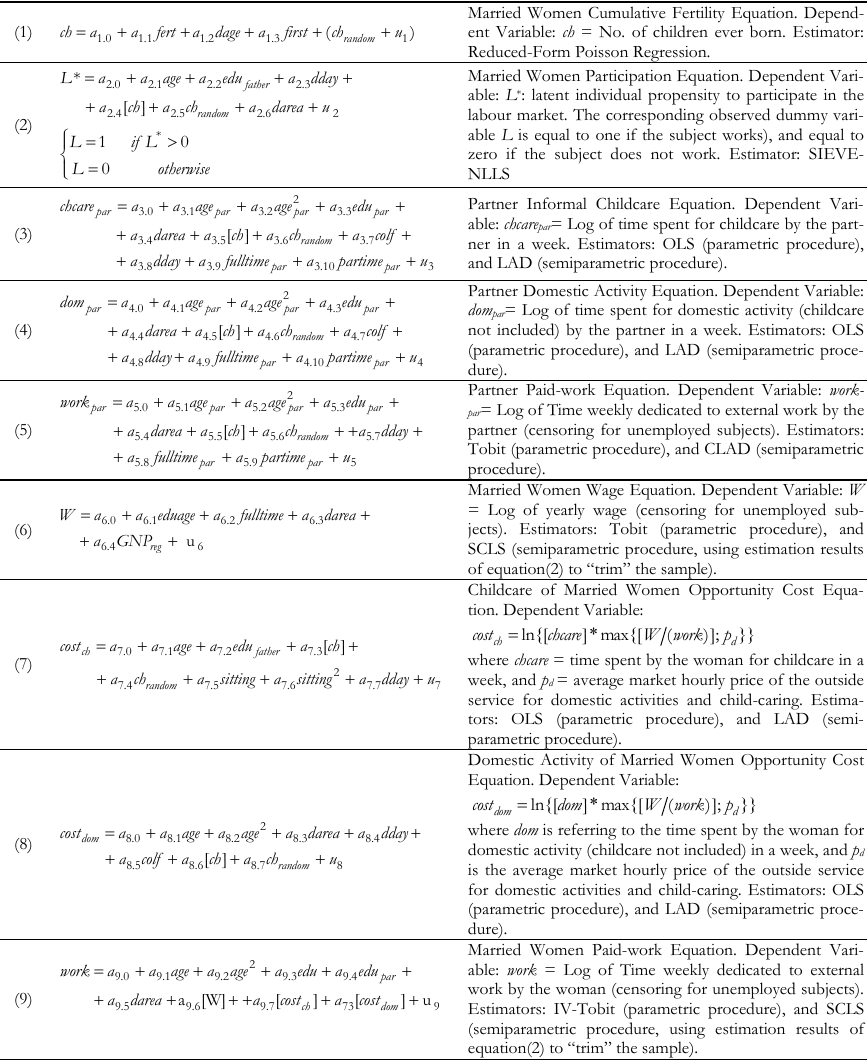
Married Women Wage Equation. Dependent Variable: W = Log of yearly wage (censoring for unemployed sub- jects). Estimators: Tobit (parametric procedure), and SCLS (semiparametric procedure, using estimation results of equation(2) to “trim” the sample). Childcare of Married Women Opportunity Cost Equa- tion. Dependent Variable: * ln{[ ] max{[ ( )]; }} ch W work p (cid:32) where chcare = time spent by the woman for childcare in a week, and p d = average market hourly price of the outside service for domestic activities and child-caring. Estima- tors: OLS (parametric procedure), and LAD (semi- parametric procedure). Domestic Activity of Married Women Opportunity Cost Equation. Dependent Variable: * ln{[ ] max{[ )]; }} dom W work p (cid:32) where dom is referring to the time spent by the woman for domestic activity (childcare not included) in a week, and p d is the average market hourly price of the outside service for domestic activities and child-caring. Estimators: OLS (parametric procedure), and LAD (semiparametric proce- dure). Married Women Paid-work Equation. Dependent Vari- able: work = Log of Time weekly dedicated to external work by the woman (censoring for unemployed subjects). (cid:14) Estimators: IV-Tobit (parametric procedure), and SCLS (semiparametric procedure, using estimation results of equation(2) to “trim” the